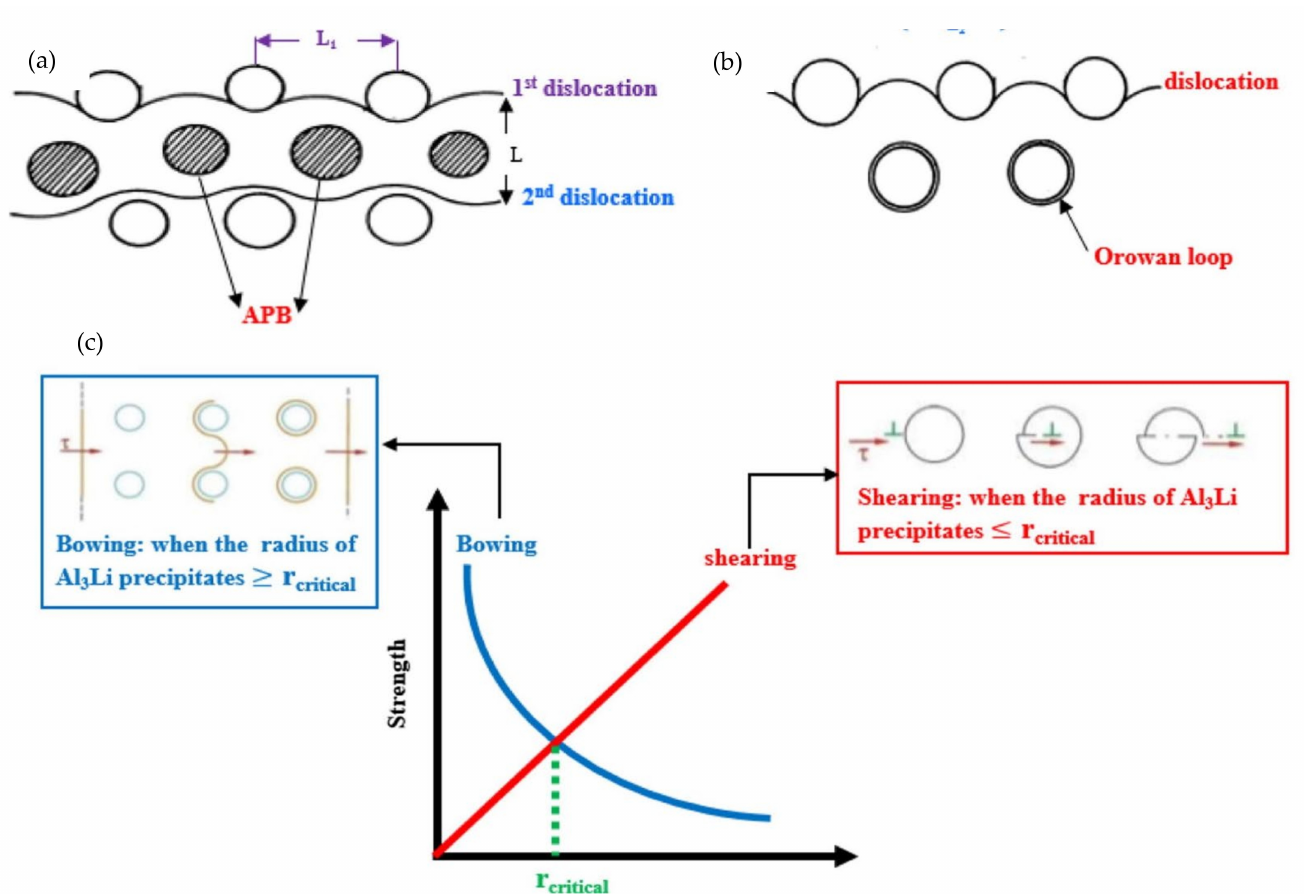
Figure 8. Schematic showing interaction modes between dislocation and precipitate particles ( a ) Shearing mechanisms ( b ) Orowan dislocation-by-pass mechanism ( c ) the comparison between shearing and bowing mechanism in terms of strength as a function of precipitate size. Adapted from